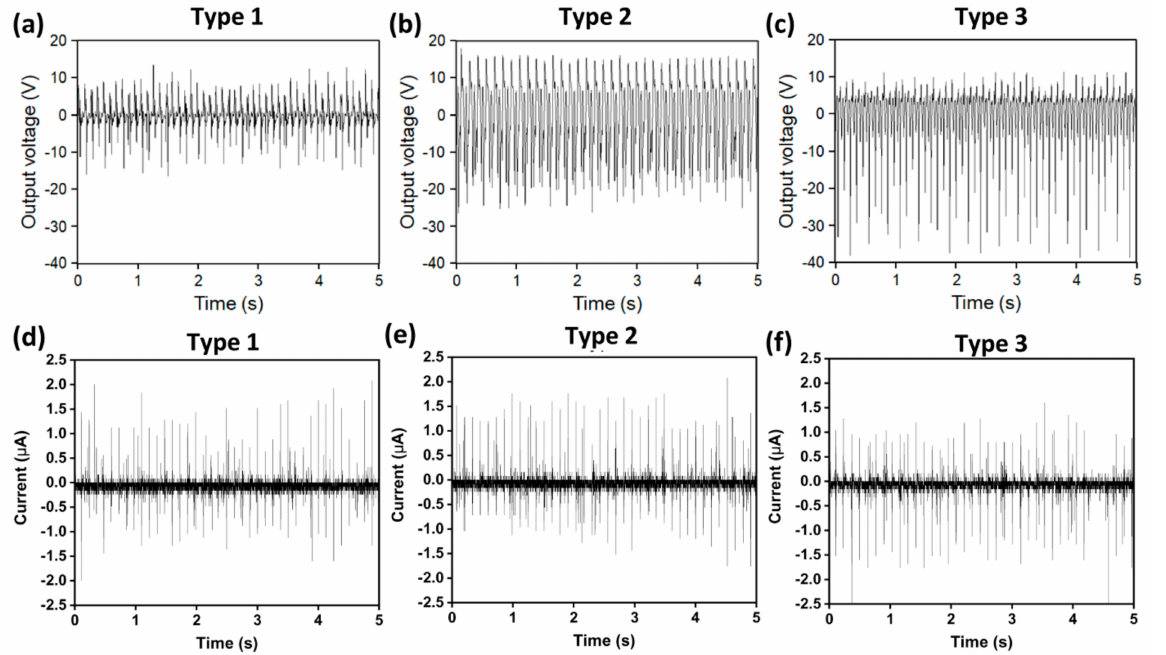
Figure 4. The output voltages ( a – c ) and currents ( d – f ) of Type 1–3 TENGs.